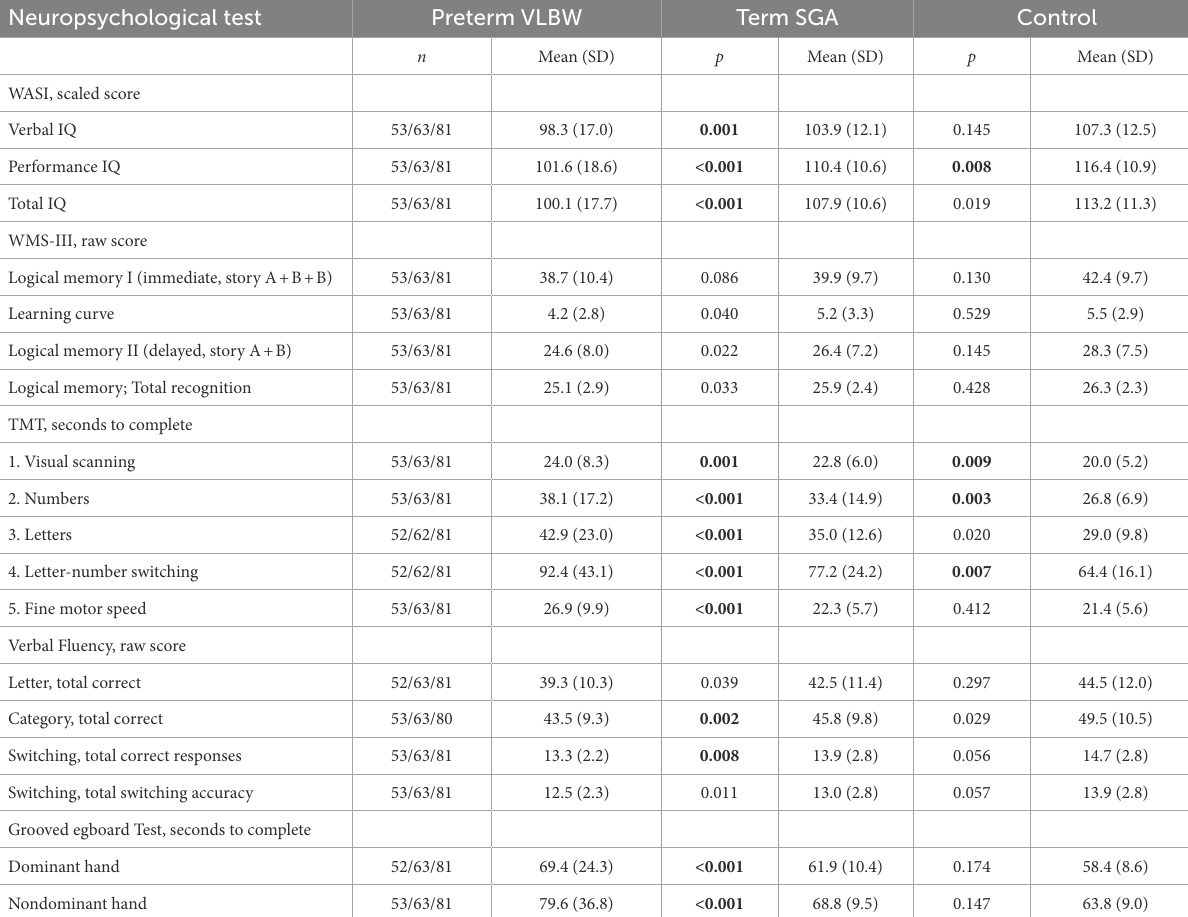
TABLE 2 Cognitive tests at 26 years of age in the three study groups. Neuropsychological